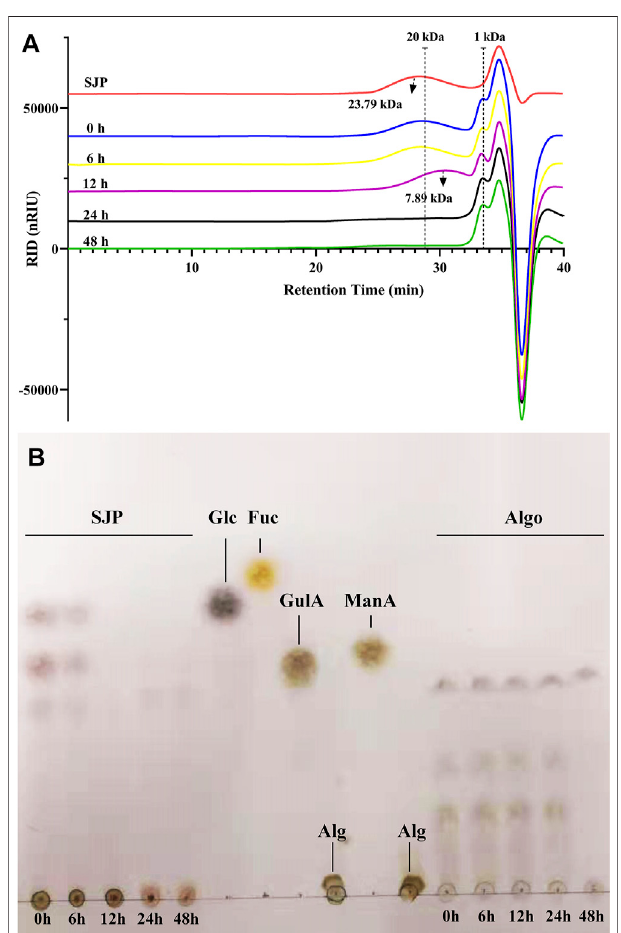
FIGURE 2 | SJP utilization during in vitro human fecal treatment. (A) HPSEC pro fi les depicting SJP utilization. (B) TLC pro fi les depicting the degradation of oligosaccharides in SJP and Algo samples. The major monosaccharides in SJP including glucose (Glc), mannuronic acid (ManA), guluronic acid (GulA), and fucose (Fuc) and the origin alginate sample (Alg) were used for reference. SJP, seaweed Laminaria japonica polysaccharides; HPSEC, high-performance size exclusion chromatography; TLC, thin-layer chromatography.